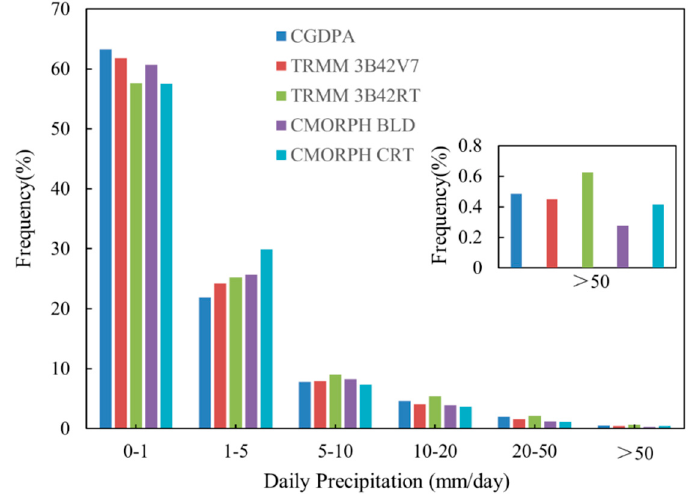
Figure 6. The occurrence frequencies of different daily precipitation products during 2006–2013 based on mean aerial precipitation.